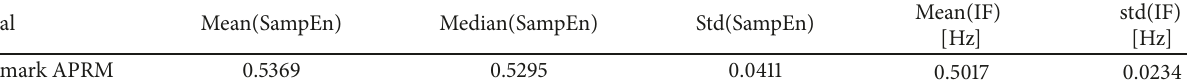
Table 3: Mean(SampEn), Median(SampEn), and std(Sampen) of the analyzed APRM. Now the mean(IF) and std(IF) are included.